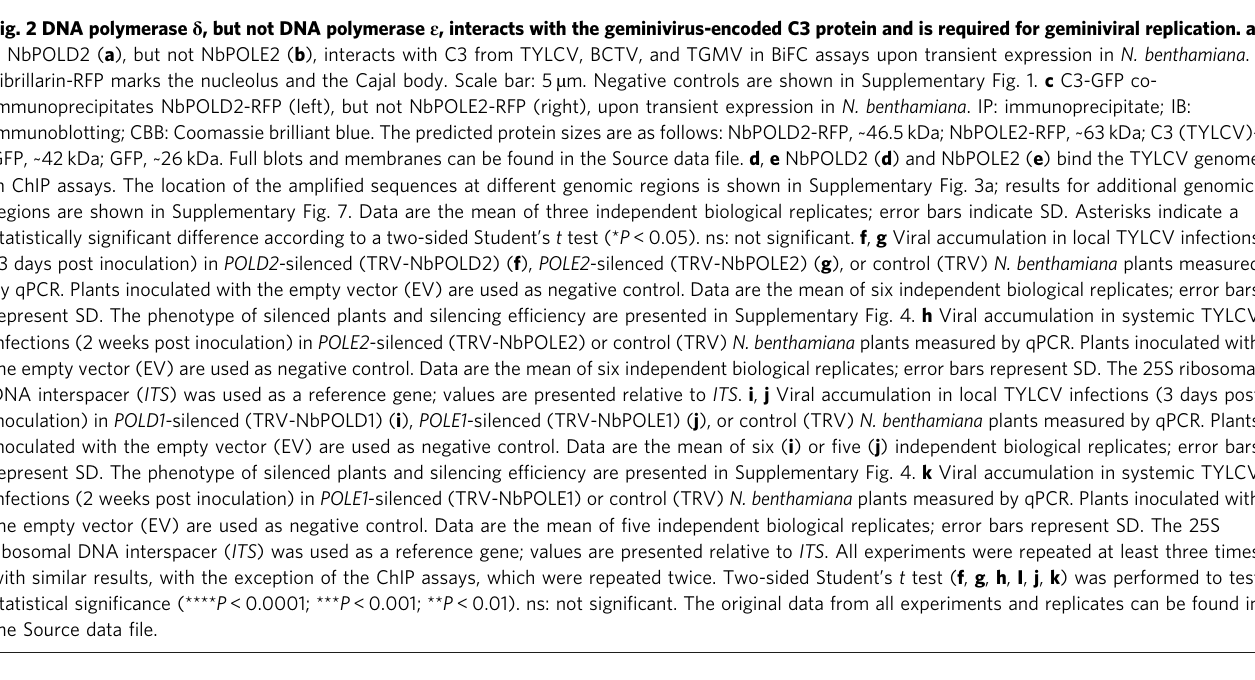
Fig. 2 DNA polymerase δ , but not DNA polymerase ε , interacts with the geminivirus-encoded C3 protein and is required for geminiviral replication. a , b NbPOLD2 ( a ), but not NbPOLE2 ( b ), interacts with C3 from TYLCV, BCTV, and TGMV in BiFC assays upon transient expression in N. benthamiana . Fibrillarin-RFP marks the nucleolus and the Cajal body. Scale bar: 5 µ m. Negative controls are shown in Supplementary Fig. 1. c C3-GFP co- immunoprecipitates NbPOLD2-RFP (left), but not NbPOLE2-RFP (right), upon transient expression in N. benthamiana . IP: immunoprecipitate; IB: immunoblotting; CBB: Coomassie brilliant blue. The predicted protein sizes are as follows: NbPOLD2-RFP, ~46.5 kDa; NbPOLE2-RFP, ~63 kDa; C3 (TYLCV)- GFP, ~42 kDa; GFP, ~26 kDa. Full blots and membranes can be found in the Source data fi le. d , e NbPOLD2 ( d ) and NbPOLE2 ( e ) bind the TYLCV genome in ChIP assays. The location of the ampli fi ed sequences at different genomic regions is shown in Supplementary Fig. 3a; results for additional genomic regions are shown in Supplementary Fig. 7. Data are the mean of three independent biological replicates; error bars indicate SD. Asterisks indicate a statistically signi fi cant difference according to a two-sided Student ’ s t test (* P < 0.05). ns: not signi fi cant. f , g Viral accumulation in local TYLCV infections (3 days post inoculation) in POLD2- silenced (TRV-NbPOLD2) ( f ), POLE2 -silenced (TRV-NbPOLE2) ( g ), or control (TRV) N. benthamiana plants measured by qPCR. Plants inoculated with the empty vector (EV) are used as negative control. Data are the mean of six independent biological replicates; error bars represent SD. The phenotype of silenced plants and silencing ef fi ciency are presented in Supplementary Fig. 4. h Viral accumulation in systemic TYLCV infections (2 weeks post inoculation) in POLE2 -silenced (TRV-NbPOLE2) or control (TRV) N. benthamiana plants measured by qPCR. Plants inoculated with the empty vector (EV) are used as negative control. Data are the mean of six independent biological replicates; error bars represent SD. The 25S ribosomal DNA interspacer ( ITS ) was used as a reference gene; values are presented relative to ITS . i , j Viral accumulation in local TYLCV infections (3 days post inoculation) in POLD1- silenced (TRV-NbPOLD1) ( i ), POLE1 -silenced (TRV-NbPOLE1) ( j ), or control (TRV) N. benthamiana plants measured by qPCR.